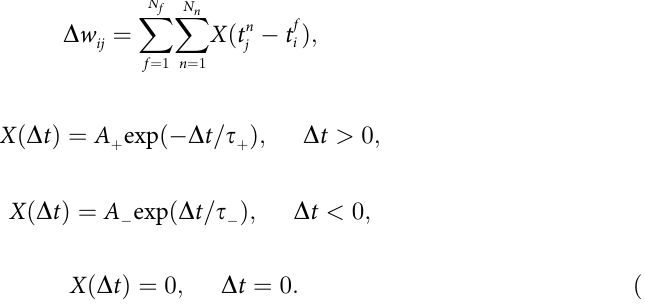
W total 20 nS A + 0.05 nS A − 0.05 nS τ + 20 ms τ − 20 ms Simulation parameter values which are not listed in the text and which are shared across all